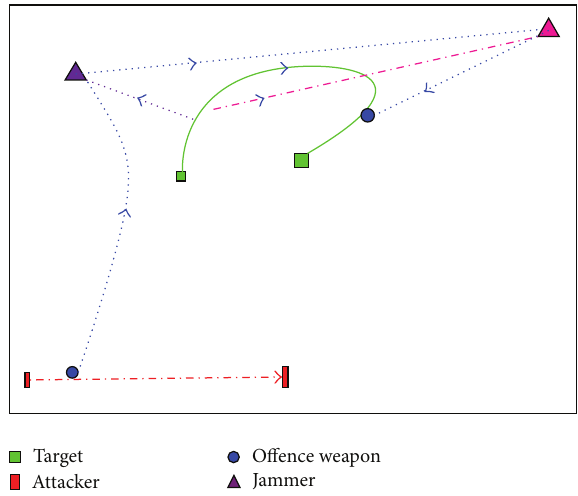
Figure 7: Scenario of the stochastic defense simulation